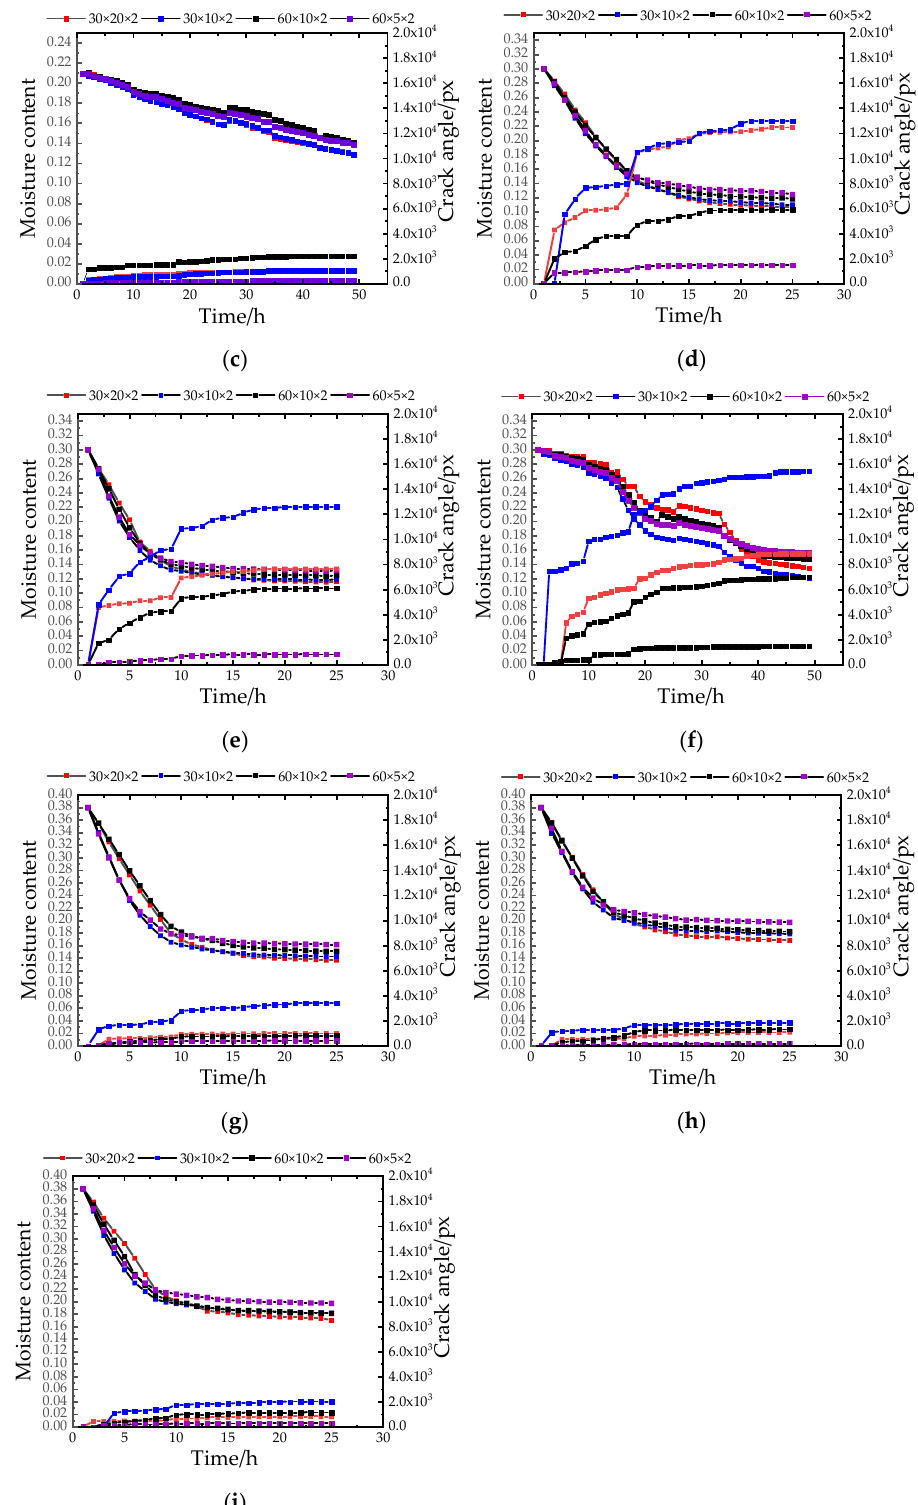
Figure 9. Crack angle change curve. ( a ) the change curve of crack angle under 21% initial moisture content and 30% humidity; ( b ) the change curve of crack angle under 21% initial moisture content and 67% humidity; ( c ) the change curve of crack angle under 21% initial moisture content and 95% humidity; ( d ) the crack angle change curve under 30% initial moisture content and 30% humidity, ( e ) the crack angle change under 30% initial moisture content and 67% humidity Curve; ( f ) the